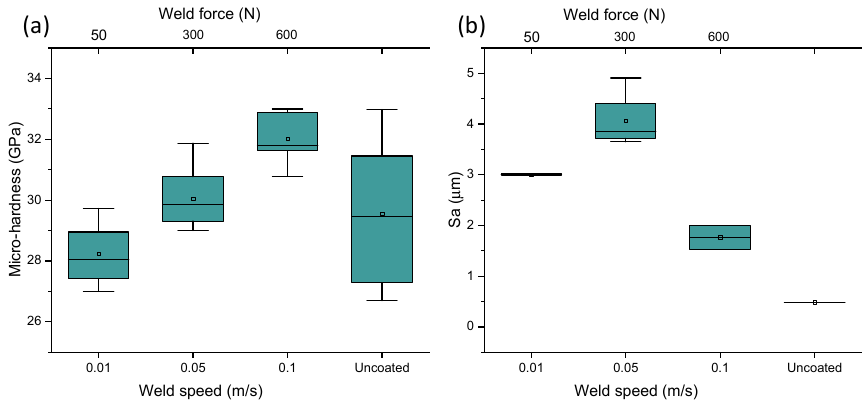
Figure 9. ( a ) Boxplot of the variation of micro-hardness as a function of weld force and weld speed, ( b ) boxplot of the effect of weld speed and weld force on the 3D surface roughness coating variation.